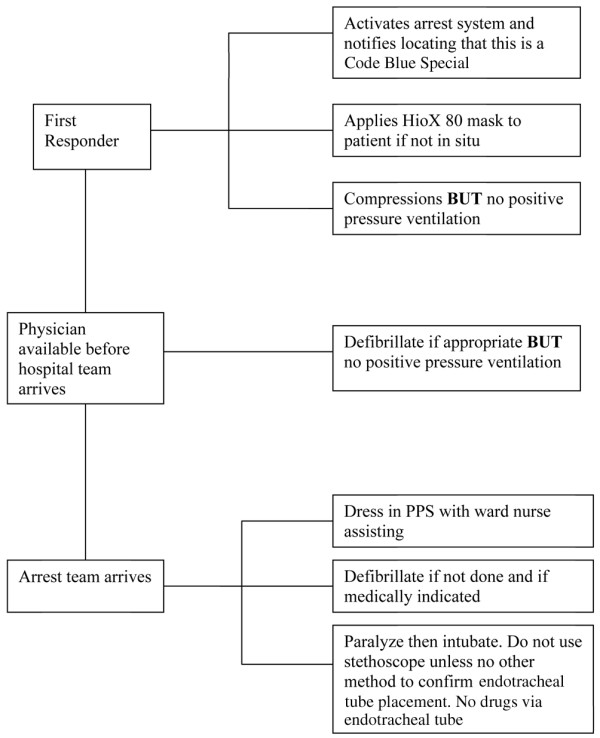
Summary of algorithm for cardiac arrest protocol (Code Blue Special) for a SARS patient.